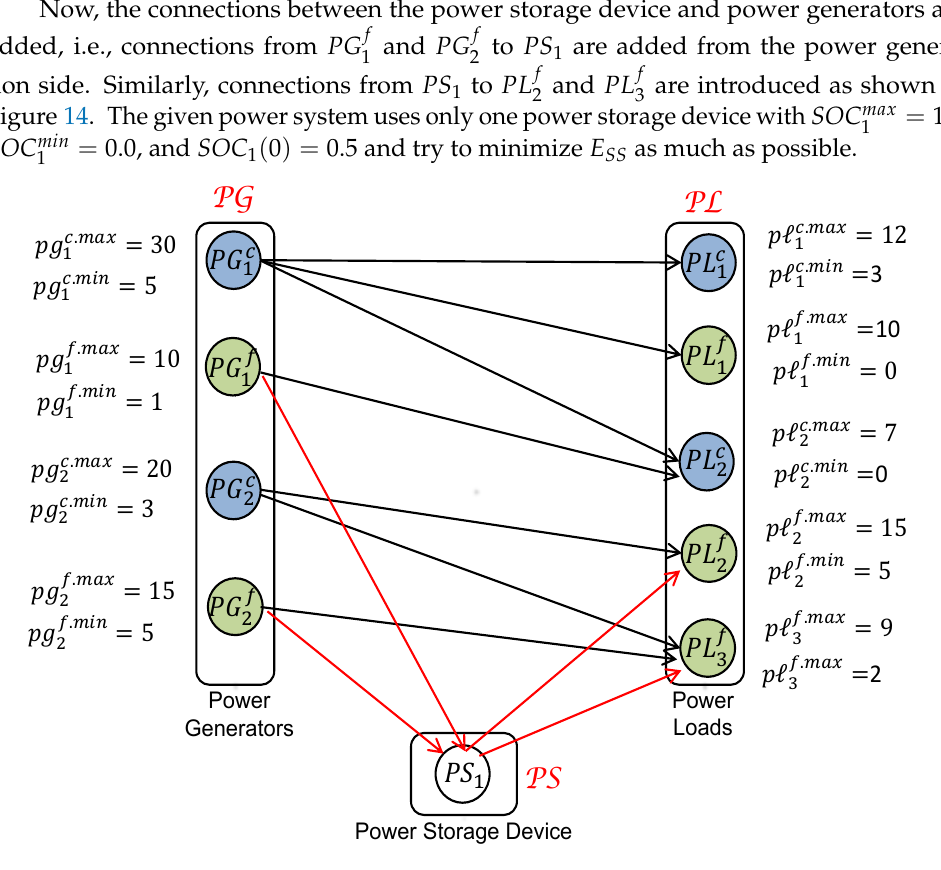
Figure 14. Example demonstration when a power storage device is involved with several